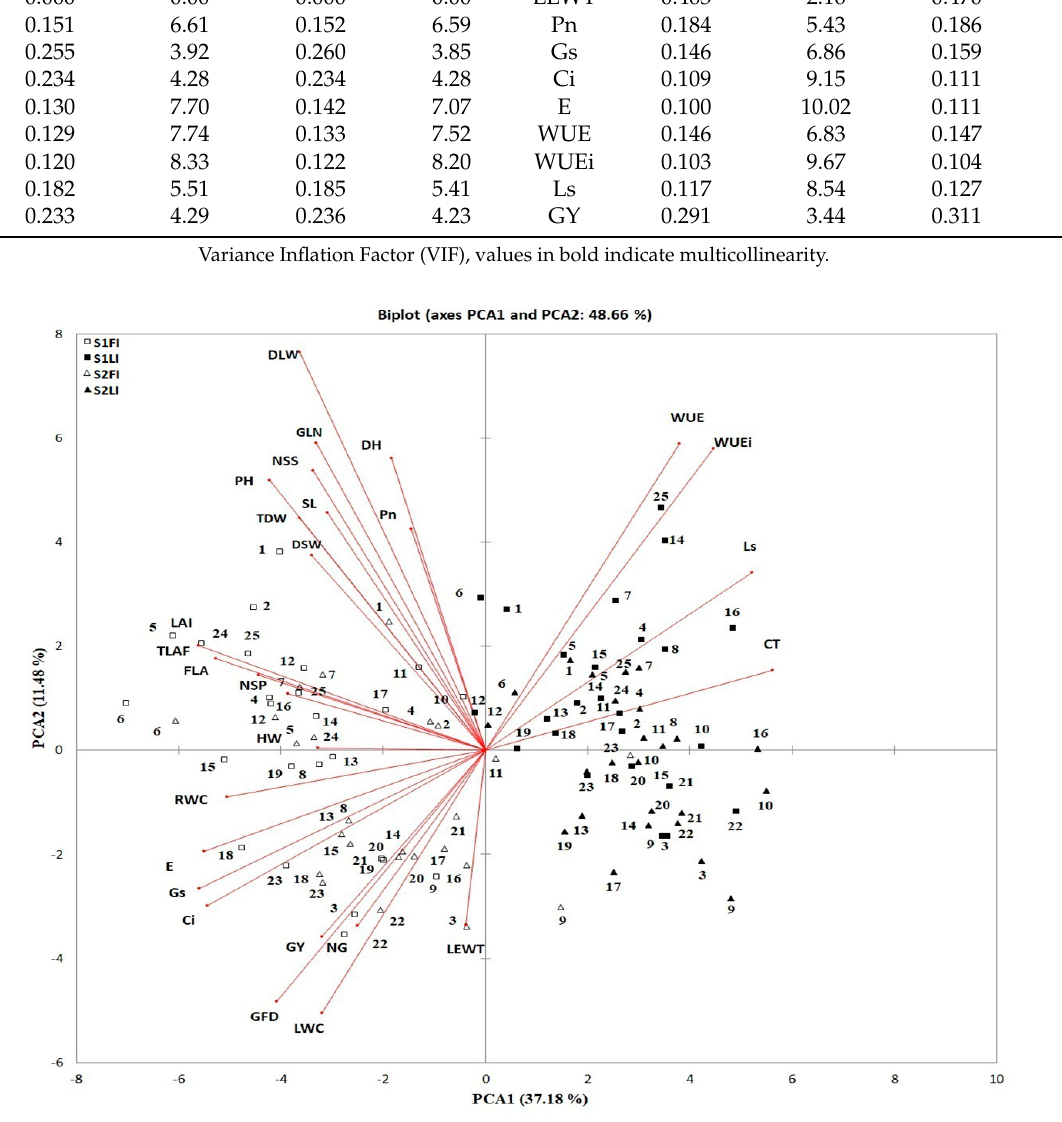
Figure 1. Biplot for the first two principal components in the principal component analysis (PCA) for 27 measured traits of 25 wheat genotypes in two seasons (S1 and S2) under full (FI) and limited irrigation regimes (LI). The numbers were indicated according to Table 6. Leaf water content (LWC), relative water content (RWC), canopy temperature (CT), leaf equivalent water thickness (LEWT), photosynthesis rate (Pn), stomatal conductance (Gs), intracellular CO 2 concentration (Ci), transpiration rate (E), instantaneous water use efficiency (WUE), intrinsic water use efficiency (WUEi), stomatal limitation value (Ls), green leaf number (GLN), flag leaf area (FLA), and green leaf area (GLA), leaf area index (LAI), dry stem weight (DSW), dry leaf weight (DLW), total dry weight (TDW), days to heading (DH), grain filling duration (GFD), plant height (PH), spike length.